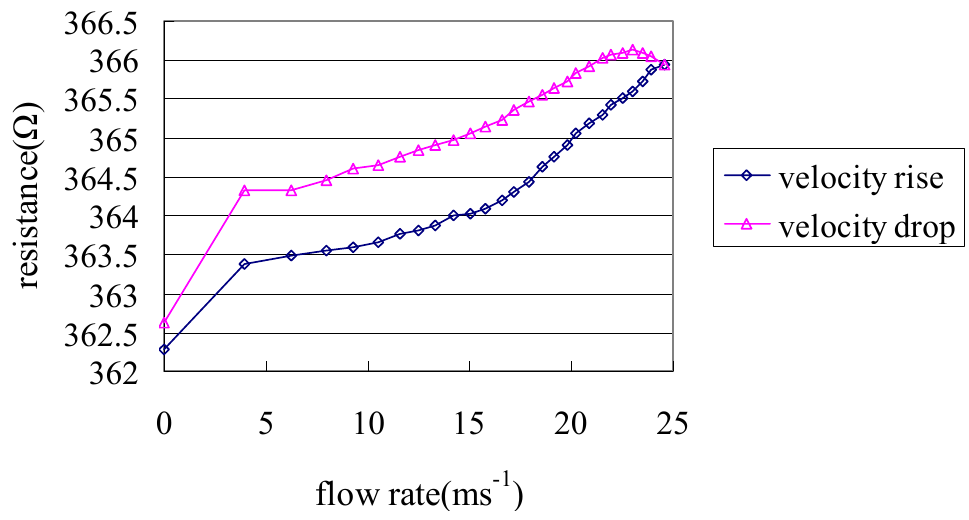
Figure 14. Sensing hysteresis of cantilever-based air flow